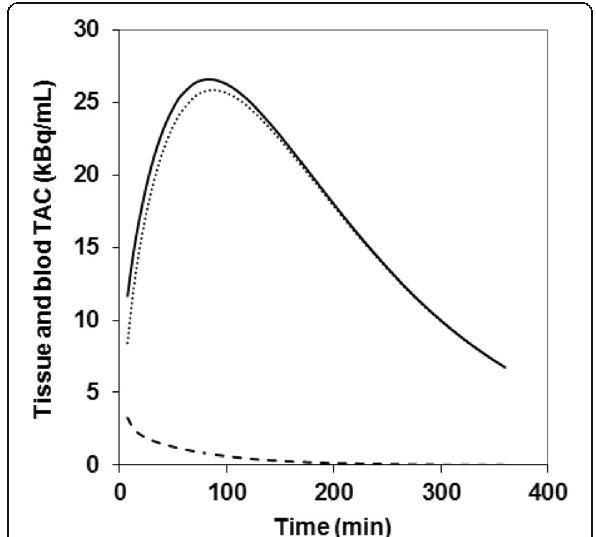
Fig. 6 (Full) Average tissue TAC obtained from mean values of the kinetic parameters (Ki, k b , V b ) found over current lung cancer series; (dotted) trapped tracer TAC; (dashed) TAC of free tracer in blood and interstitial volume. Peak time for tissue TAC and trapped tracer TAC is 84 and 88 min, respectively. Data are uncorrected for 18